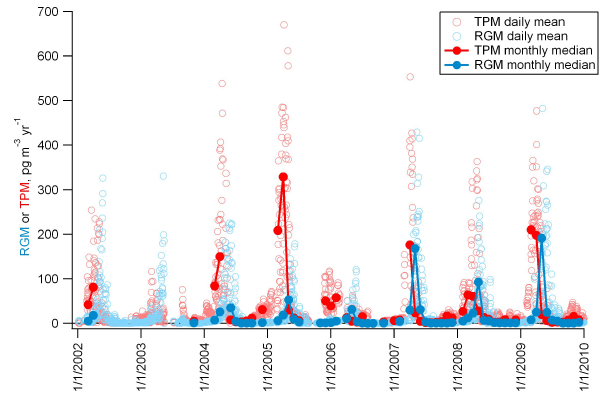
Fig. 6. Seasonal (monthly) trends in GEM, TPM and RGM from Alert based on daily average measurements, 2002–2009. Error bars represent 95% confidence limits.